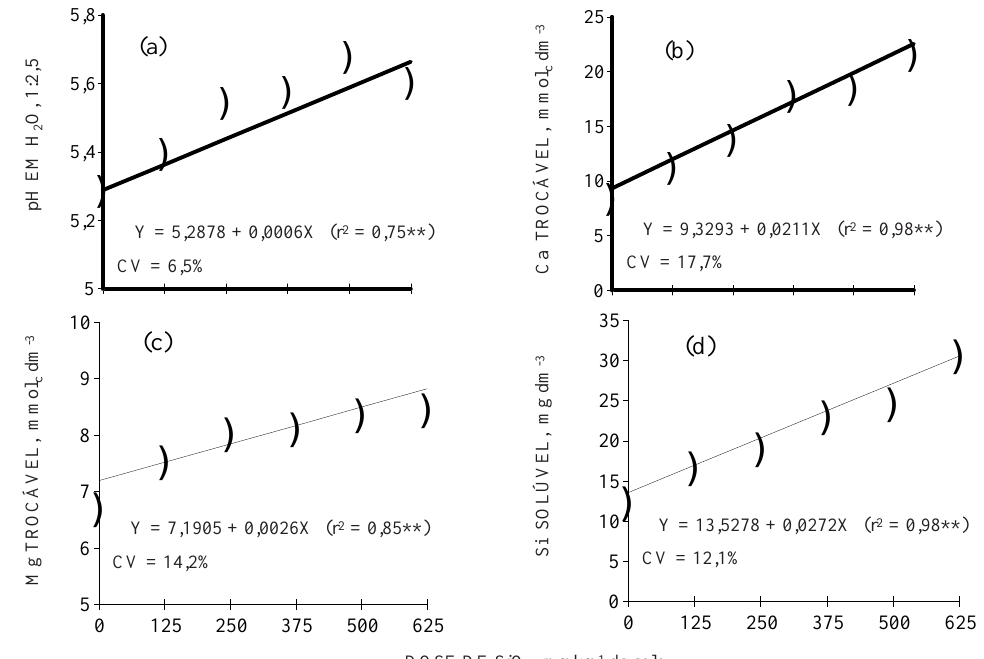
Figura 2. Características de solo influenciadas pela aplicação de doses de SiO Vermelho-Escuro distrófico (a) pH em água, (b) Ca trocável, (c) Mg trocável e Si solúvel (ácido acético 0,5 mol L -1 ). **, *** indicam P < 0,01 e P < 0,001,